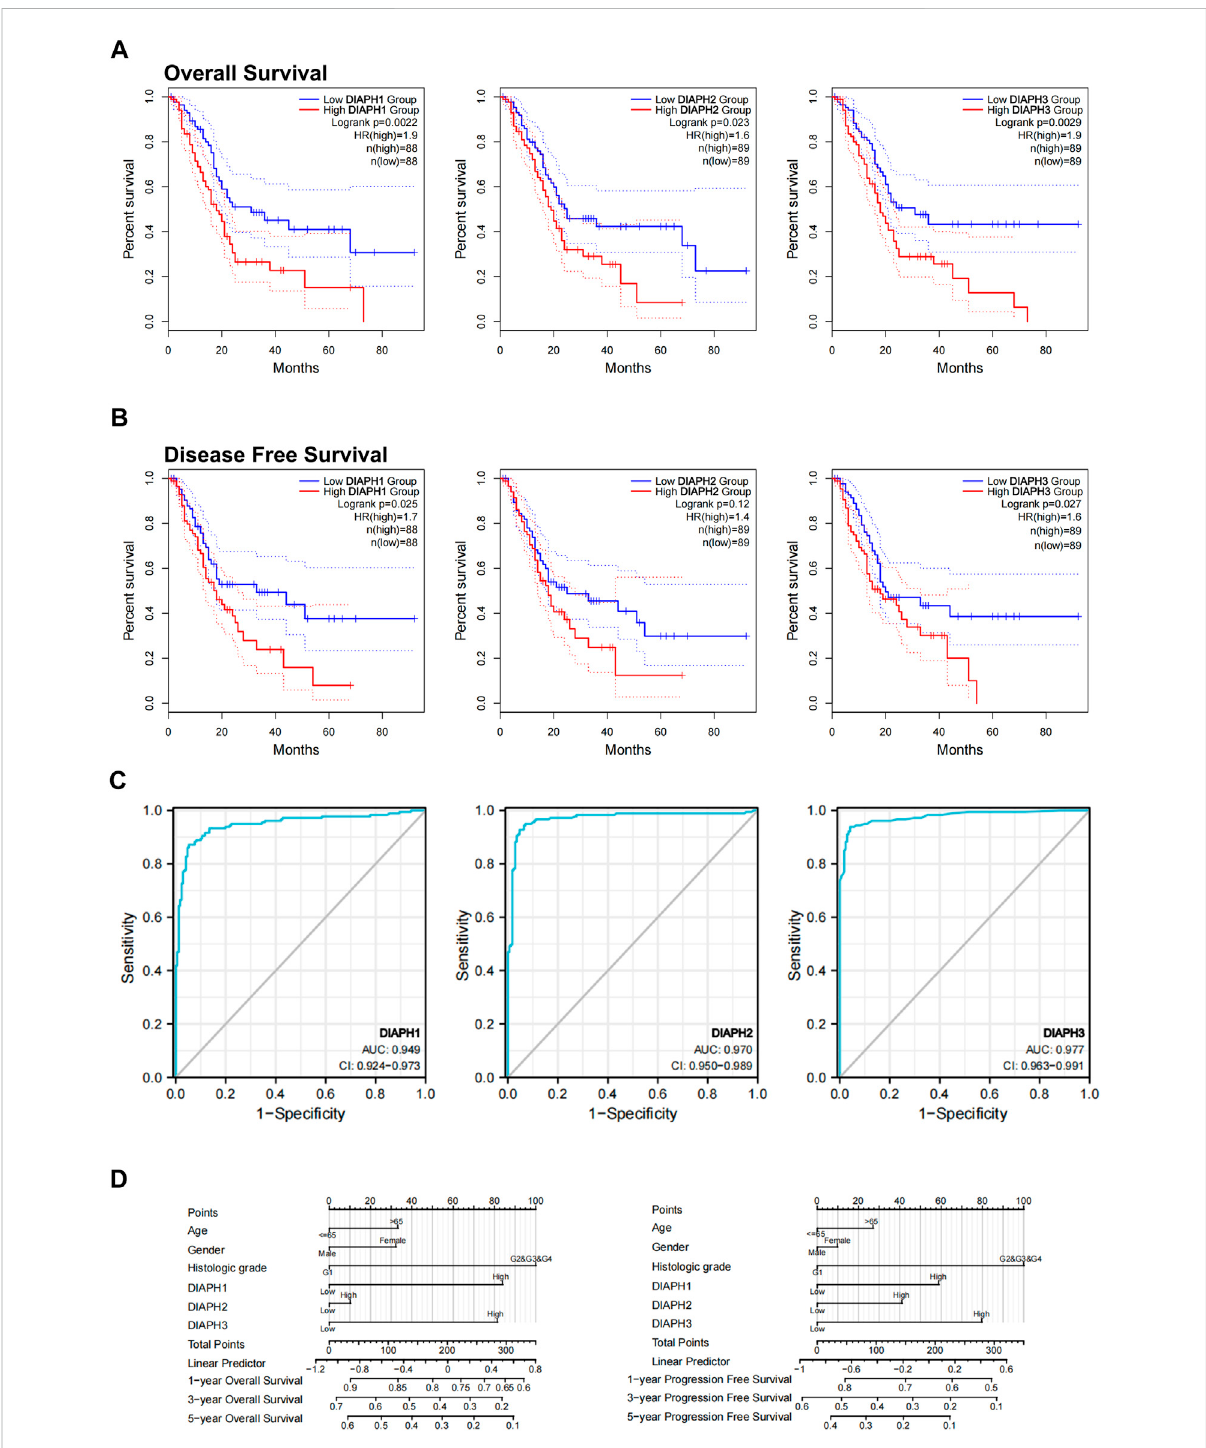
FIGURE 3 Relations between DIAPHs expression and prognosis of PAAD in TCGA database. (A – B) Overall survival and disease-free survival analyses between the DIAPHs high-expression and low-expression cohort. High-cutoff (50%) and low-cutoff (50%) values were used as the expression thresholds for separating the high-expression and low-expression cohorts, in log-rank test. HR, hazard ratio. (C) AUC of DIAPH1, DIAPH2, and DIAPH3 expression for PAAD. AUC, area under ROC curve. (D) DIAPHs as risk factors in nomograms for overall survival and progression-free survival in patients with